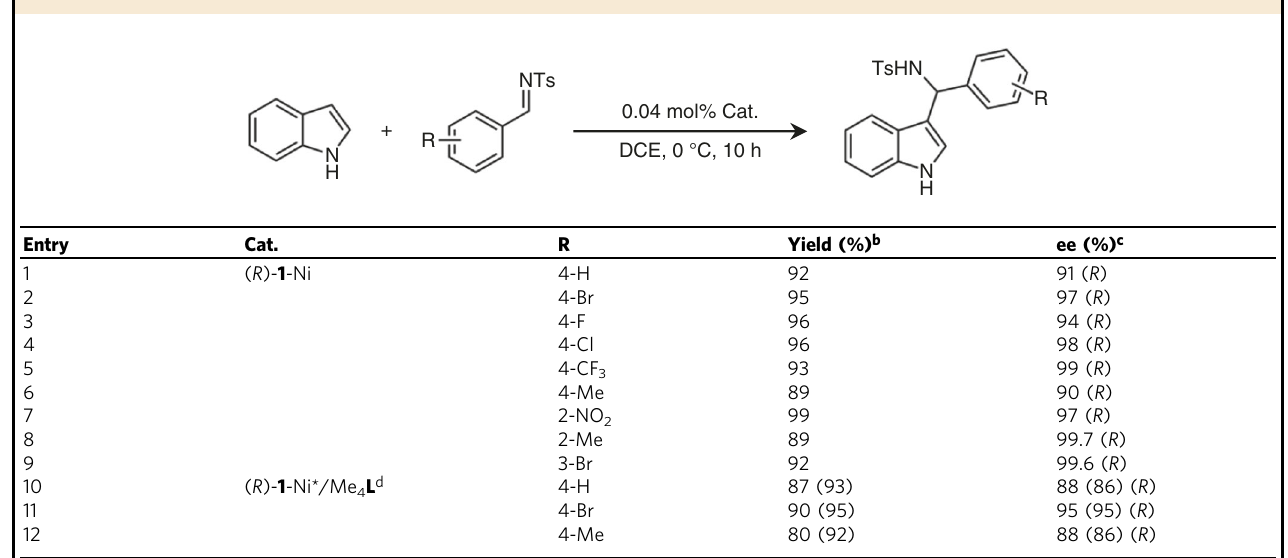
Table 2 Asymmetric Friedel-Crafts reaction of N -sulfonyl aldimines with indole